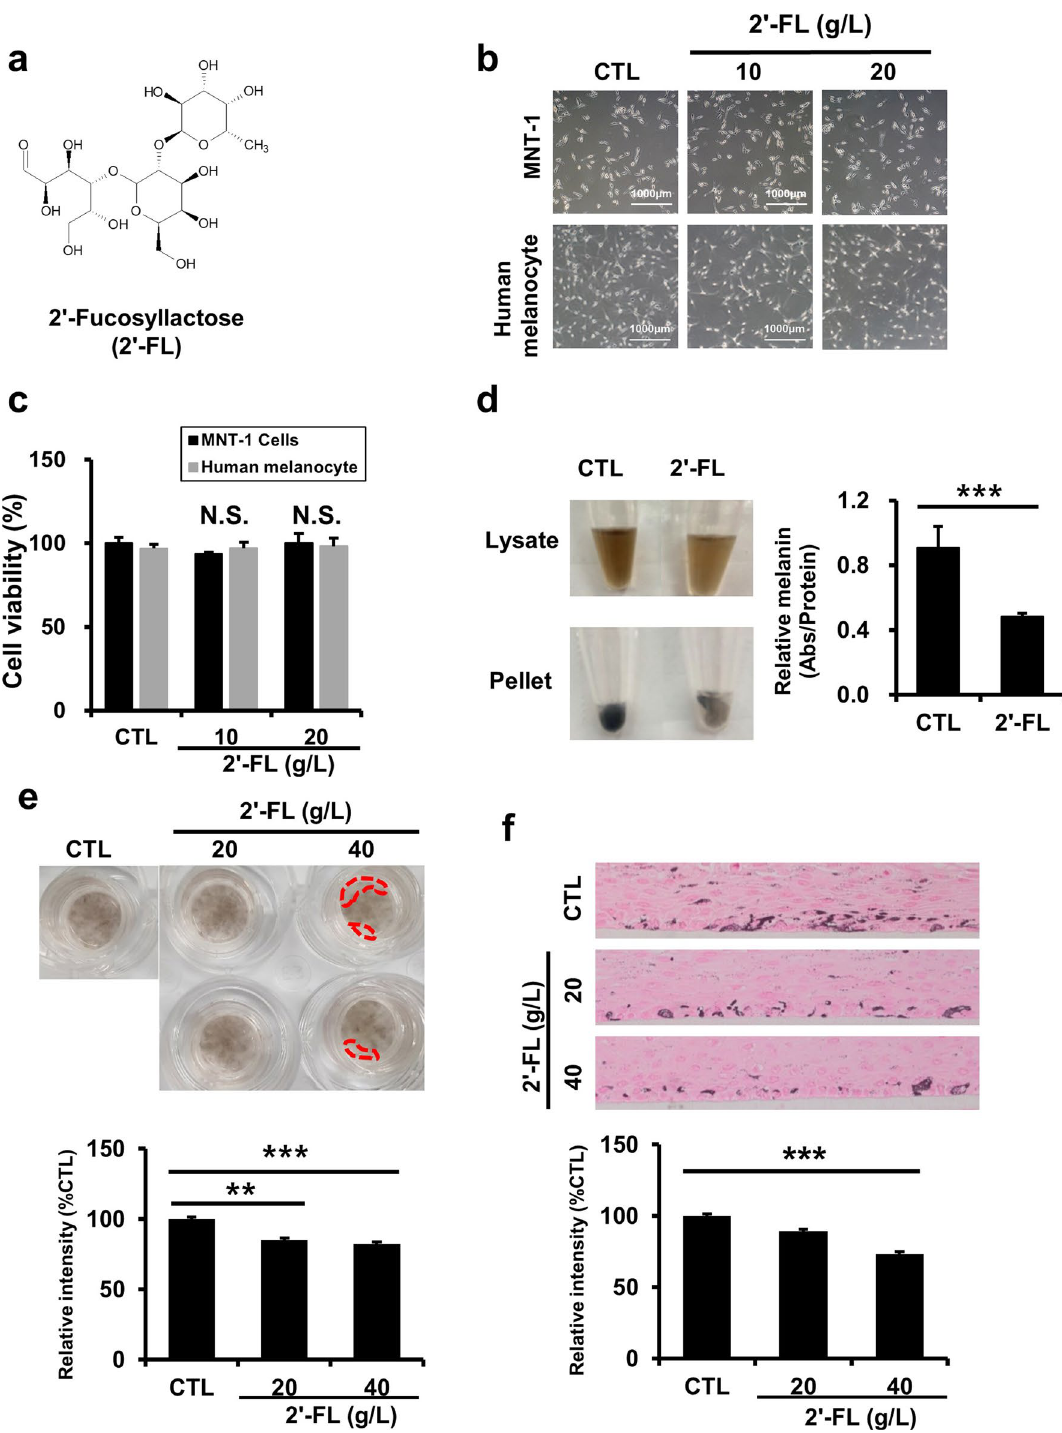
Figure 1. 2’-Fucosyllactose reduces melanin production. ( a ) Chemical structure of 2’-FL. ( b ) Cell morphology of human melanocytes and MNT-1 cells without or with 2’-FL (10 or 20 g/L) for 24 h. ( c ) Cell viability of human melanocytes and MNT-1 cells treated with 2’-FL (10 or 20 g/L) for 24 h measured by MTT assays. Cell viability is presented in relation to nontreated cells. ( d ) Melanin levels in mouse B16 cells with or without 2’-FL (20 g/L) for 7 days. Optical densities (450 nm) are presented in relation to nontreated cells. Data in ( c ) and ( d ) are represented as mean ± SD of three replicates. * P < 0.05, *** P < 0.001 by one-way ANOVA with Dunnett’s post- hoc test ( c ) or Student’s t -test ( d ). ( e ) Melanin levels in human artificial skin treated with 2’-FL (20 or 40 g/L) for 7 days by spectrophotometric (a; n = 3 per group) and Fontana-Masson staining (b; n = 3 per group) assays. Data are represented as mean ± SD. ** P < 0.01 by one-way ANOVA with Dunnett’s post-hoc test. Dotted area in ( f ) shows where pigmentation was reduced. Intensity of control (CTL) samples was used for normalization. Data are represented as mean ± SD. * P < 0.05 by one-way ANOVA with Dunnett’s post-hoc